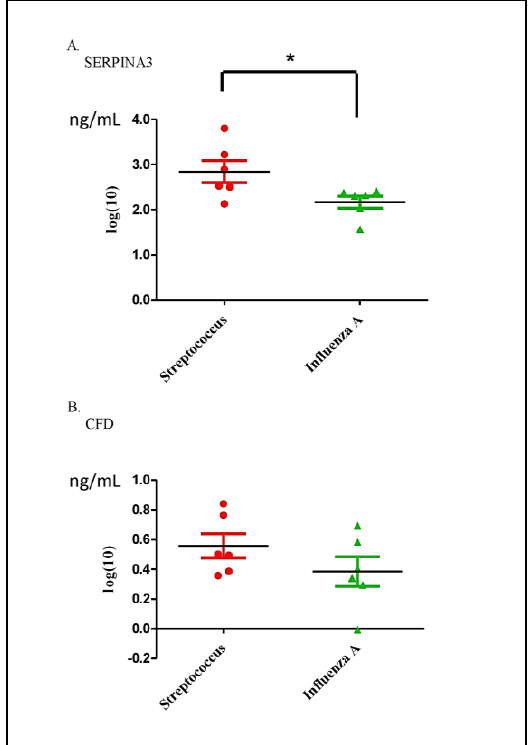
Figure 4. ( A ) Salivary alpha 1-antichymotrypsin (SERPINA3) and ( B ) complement factor D (CFD) levels in Streptococcus pneumoniae and influenza A virus groups. The SERPINA3 and CFD levels were determined with ELISA and compared with a non-parametric method. Due to low concentration, data are transformed to Log10 for presentation. * p <